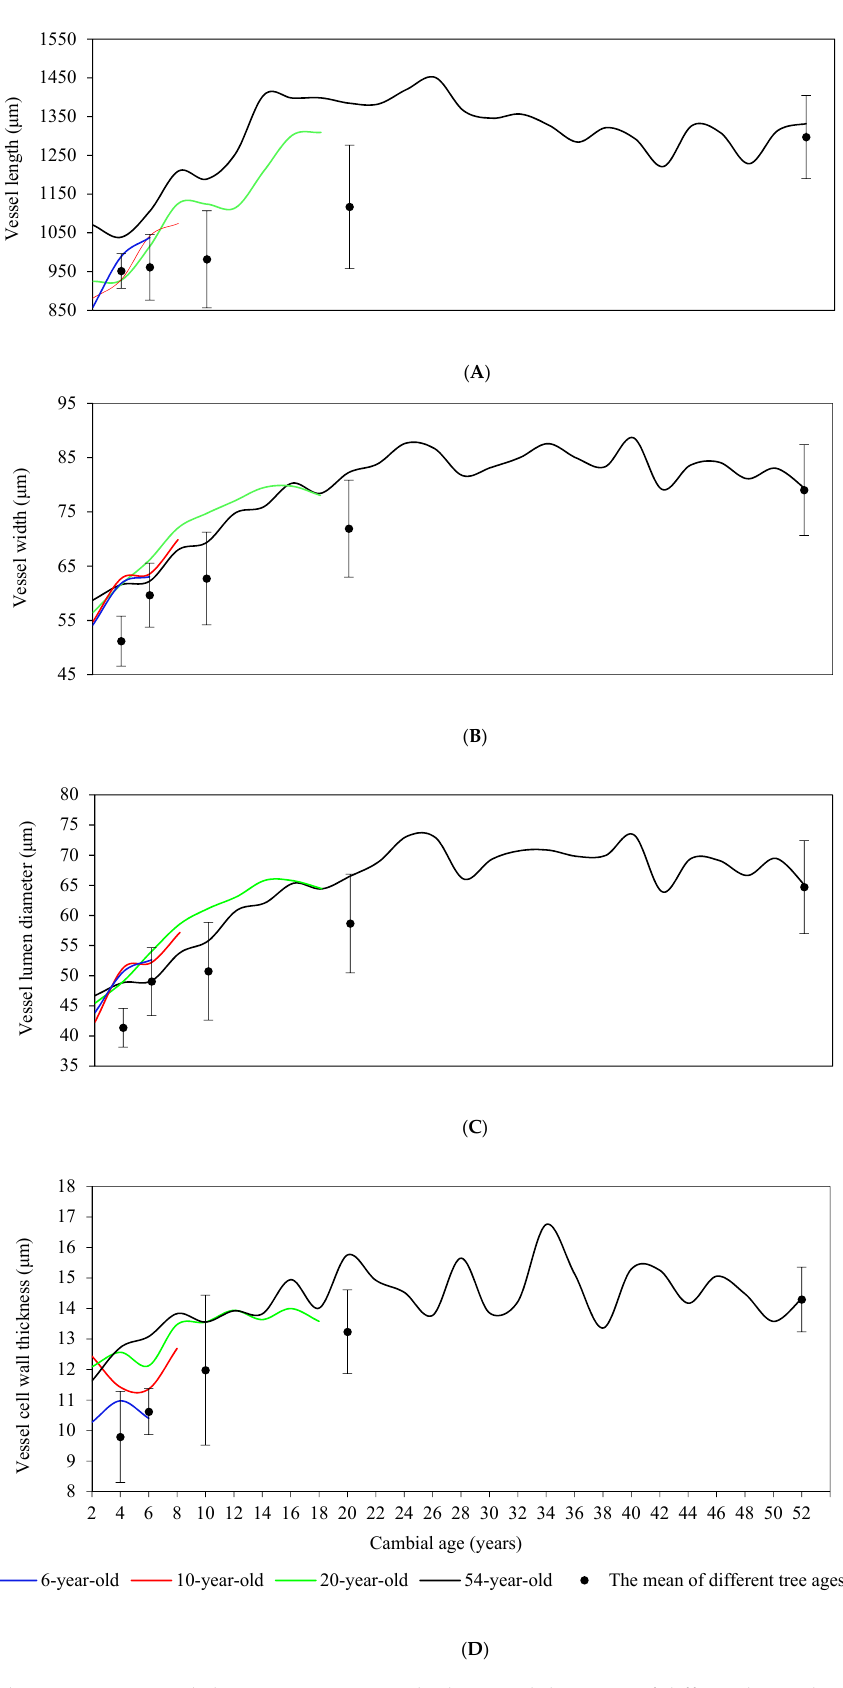
Figure 5. The radial variation in vessel characters versus cambial age and the mean of differently aged S. superba, including vessel length ( A ), vessel width ( B ), vessel lumen diameter ( C ) and vessel cell wall thickness ( D ).